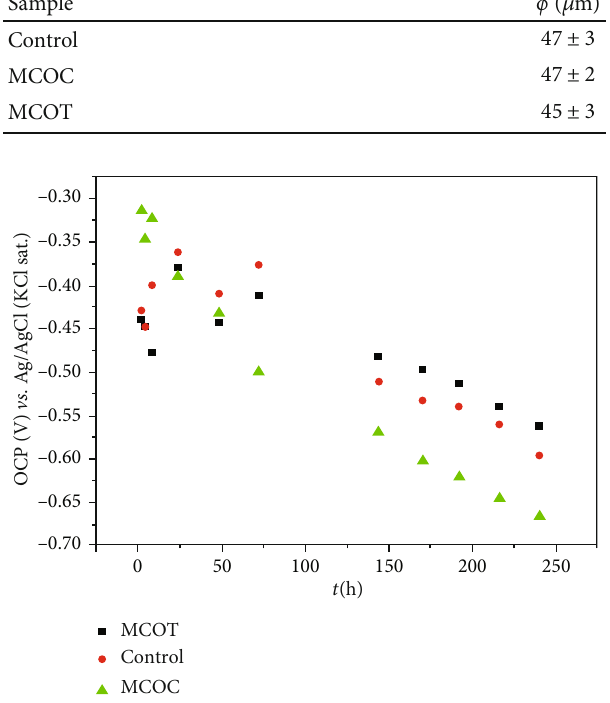
Table 1: Dry fi lm thickness ( ϕ ) analysis of applied samples. Sample